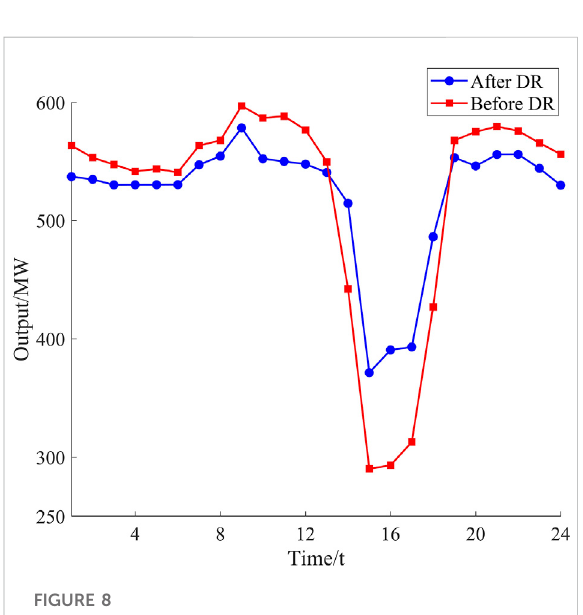
FIGURE 8 The total load comparison before and after DR.